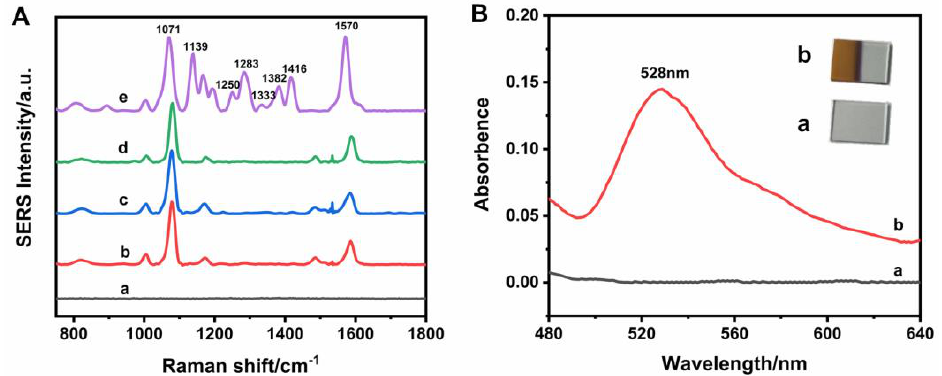
Figure 1. ( A ) SERS spectra of (a) blank AuNP/ITO chip, and (b) 4-ATP, (c) 4-ATP+ nitrite, (d) 4-ATP + NED, and (e) azo compounds on AuNP/ITO chip; ( B ) UV-Vis absorption spectra of (a) bare ITO and (b) AuNP/ITO film, the insert was the photos of their corresponding chips.